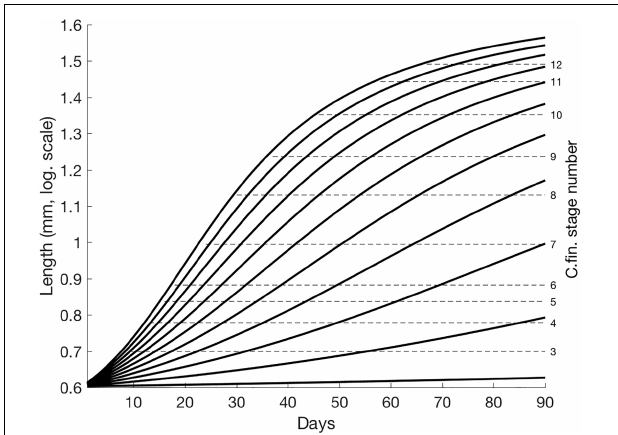
FIGURE 2 | Larval growth (logarithmic scale) according to Folkvord (2005) for fixed temperatures ranging from 1–11 ◦ C and corresponding upper threshold of available C. finmarchicus nauplii (1–6) and copepodites (7–12) stages limited by the copepod size and larval gape size. Note that newly hatched larvae are here initiated at lengths of about 4 mm. Assuming their gape size is 8% of their length enable them to initially feed upon nauplii stage